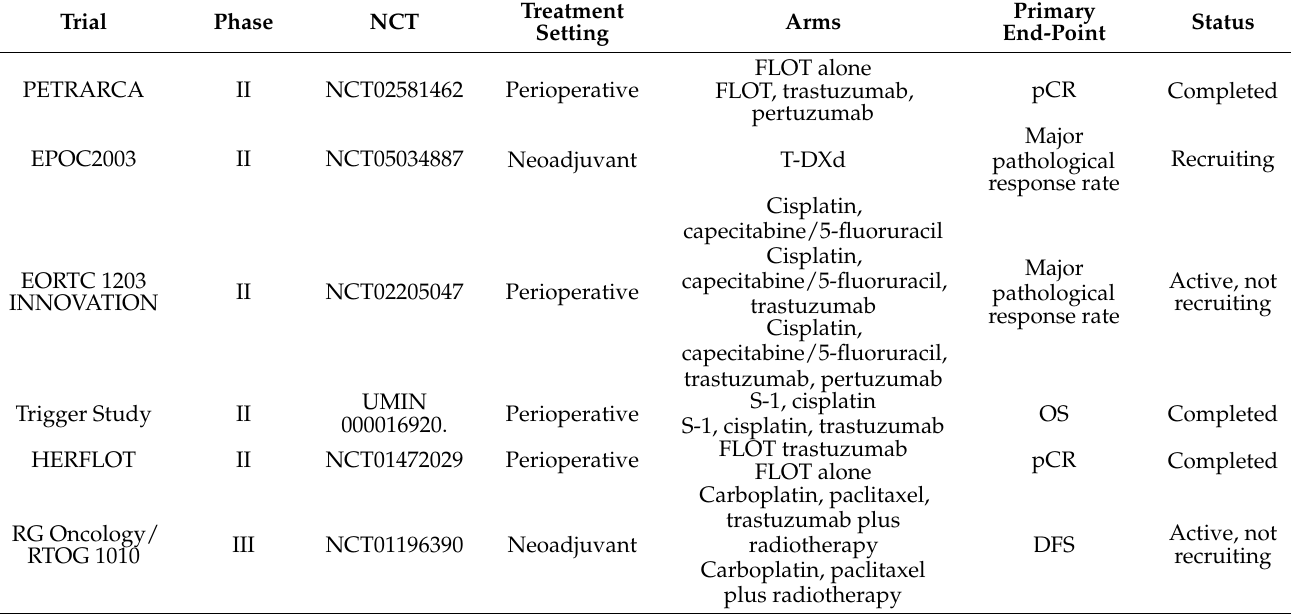
Table 1. Summary of the main trials with anti-HER2 agents in resectable G/GEJ